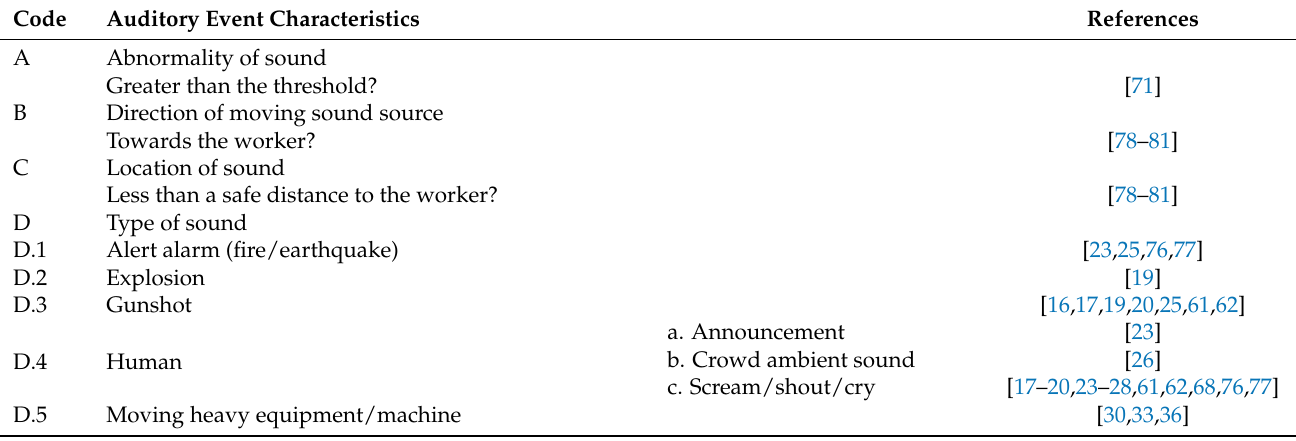
Table 8. Summary of auditory event characteristics in the construction field.